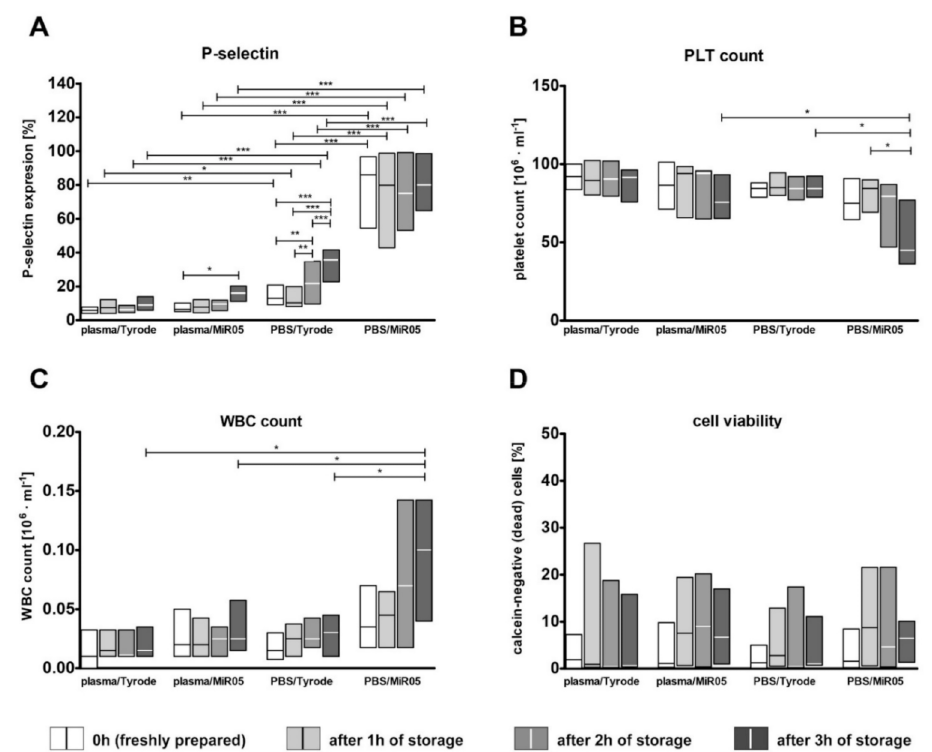
Figure 3. The effect of the storage of platelet suspension on platelet activation, platelet count and viability in samples suspended in either plasma or PBS and transferred to either MiR05 or Tyrode’s buffer at the appropriate time point of storage. Data are presented as medians (solid line within boxes) and IQRs (boxes); n = 6. P-selectin expression ( A ), platelet count ( B ), white blood cells count ( C ) and cell viability ( D ) were measured for freshly prepared platelet suspensions and after one, two and three hours of storage. The significances of the differences, as estimated with two-way ANOVA for repeated measures with Tukey’s post hoc test, were: * p < 0.05, ** p < 0.01, *** p < 0.001. Additional information about the effect of time, the effect of medium, the effect buffer is presented below: ( A ) p < 0.01 for the effect of buffer, p < 0.001 for the effect of time, p < 0.001 for the effect of medium; ( B ) p < 0.05 for the effect of time, p < 0.01 for the effect of medium, ns. for the effect of buffer; ( C ) p < 0.05 for the effect of medium, p < 0.01 for the effect of buffer, ns. for the effect of time; ( D ) ns. for the effect of time, ns. for the effect of medium, ns. for the effect of